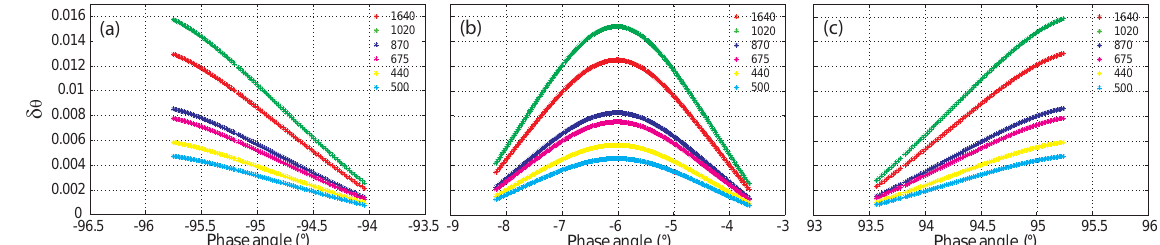
Figure 4. Predicted AOD differences from the fitting analysis with θ ( δ θ ) for different phase angles: (a) 6 April, (b) 8 October and (c) 16 Oc- tober.